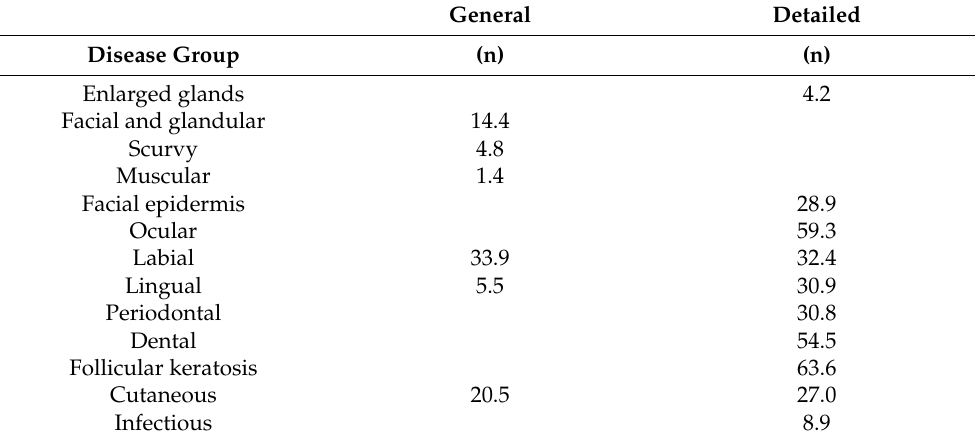
Table 7. Medical check-ups: incidence of disease per 100